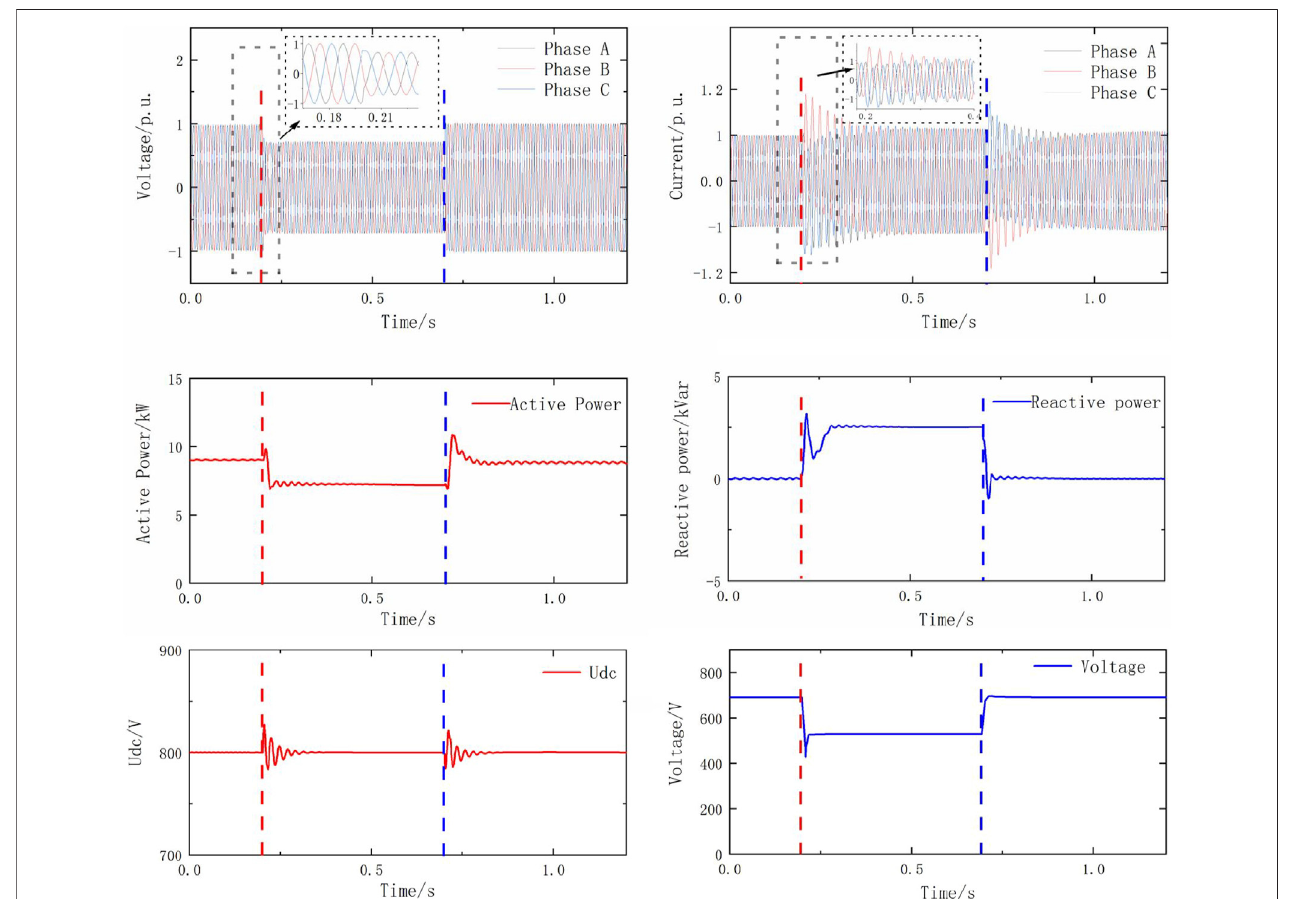
FIGURE 5 | Low-voltage crossing simulation when the voltage drops to